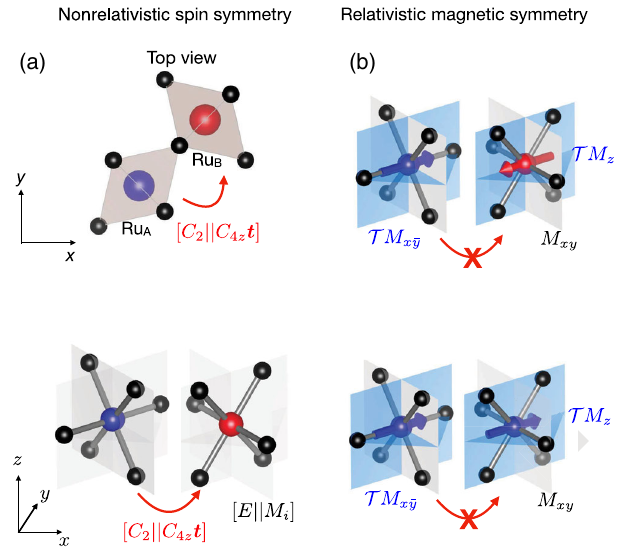
FIG. 4. (a) Schematic top view (upper panel) and 3D view (lower panel) of the RuO 2 crystal with opposite spin directions on Ru and Ru sublattices depicted in red and blue, oxygen atoms A B shown in black, and with the depicted nonrelativistic spin-group symmetries corresponding to spin group 2 4 = 1 m 2 m 1 m in the notation of Ref. [16]. The curved red arrow and its label highlight the generator of opposite-spin sublattice transformations, and the generators of the halving subgroup of same-spin sublattice transformations are also highlighted (in black). Here, C 2 on the left of the double vertical bar is a 180° spin-space rotation transformation around an axis perpendicular to the spins, and E is the spin-space identity. On the right of the double vertical bar, t is a fourfold real-space rotation combined with translation, C 4 z and M are real-space mirror transformations. (b) Schematic spin i arrangement on the RuO 2 crystal with antiparallel (upper panel) and parallel (lower panel) spin directions and the crystallographic spin-axis orientation depicted by red and blue arrows, and with the depicted generators of the relativistic magnetic symmetry group m 0 m 0 m . Here, T is time reversal. The crossed arrow highlights that the magnetic group contains no opposite spin- sublattice transformation elements. The same magnetic group describes a fully compensated antiparallel magnetic order, a parallel magnetic order with a strong nonrelativistic ferromag- netic moment, as well as an antiparallel magnetic order with a weak uncompensated relativistic magnetization [16]. This exam- ple illustrates that the relativistic magnetic groups generally do not separate between relativistic and nonrelativistic, compensated and noncompensated, or collinear and noncollinear magnetic phases. This figure is adapted from Ref.